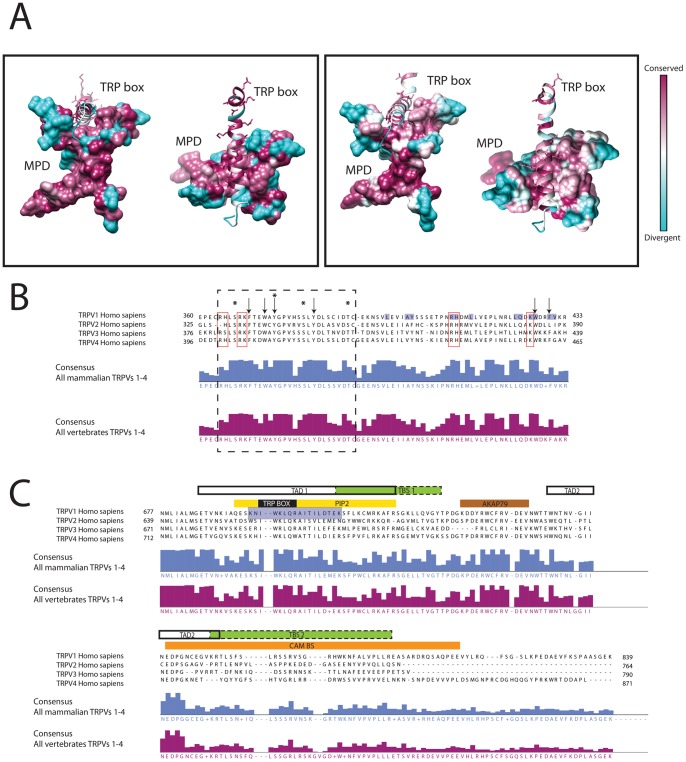
Cytosolic domains of TRPV channels.
A. Conservation plot for the TRPV1 N-terminus (surface representation) and C-terminus (ribbon representation) interaction region. The residues involved in the MPD and TRP box interaction have been selected using a 5Å threshold. The specific residues are indicated in the alignments in Fig. 5B and 5C. The left plot represents the conservation scores obtained by ConSurf [46] for all TRPV1 sequences in this study. The plot in the right represents the conservation scores for all TRPV sequences used in this study. B. MSA for the membrane proximal domain of human TRPVs. The consensus sequence and the confidence score for the whole set of mammalian and vertebrate sequences are indicated. The black dashed line box delimits a conserved domain with predicted phosphorylation sites (asterisks, see text for details). Conserved residues are highlighted, positively charged residues are framed in red, and black arrows indicate aromatic residues. Shaded residues in the TRPV1 sequence represent the contacts between the MPD and the TRP box, represented in Fig. 5A. C. MSA of the C-terminal domain of human TRPV1-4 channels. Fragment showing the alignment of the C-terminal region from the human TRPV1-4 channels. The consensus sequence and the confidence score for the whole set of mammalian and vertebrate sequences are indicated. Specific structural/regulatory domains are indicated; TAD, tetramerization domain, commonly known as TRP domain; TBS, tubulin-binding sequence; PIP2, Phosphatidylinositol 4,5-bisphosphate binding sequence; AKAP79; CAM BS, calmodulin binding sequence. The alignments were plotted using JalView 2.8 [14]. Shaded residues in the TRPV1 sequence represent the contacts between the MPD and the TRP box, represented in Fig. 5A.